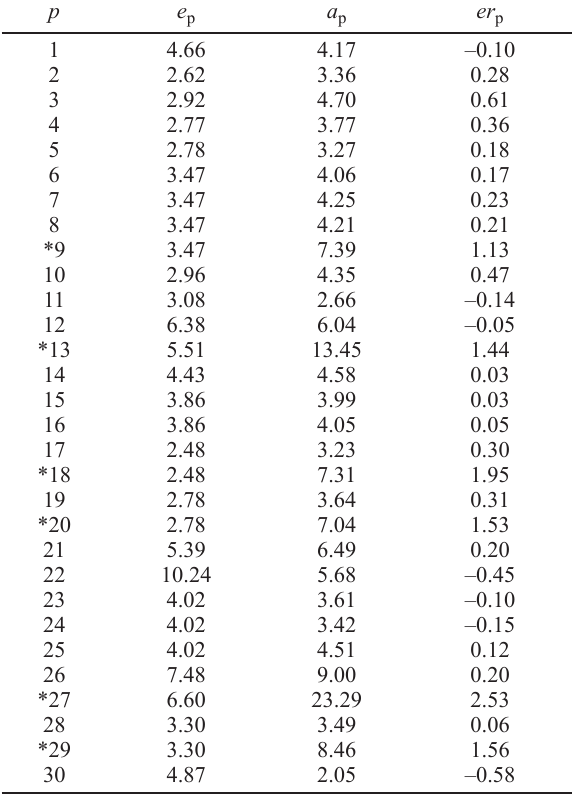
Table 1. A sample of unit costs (*